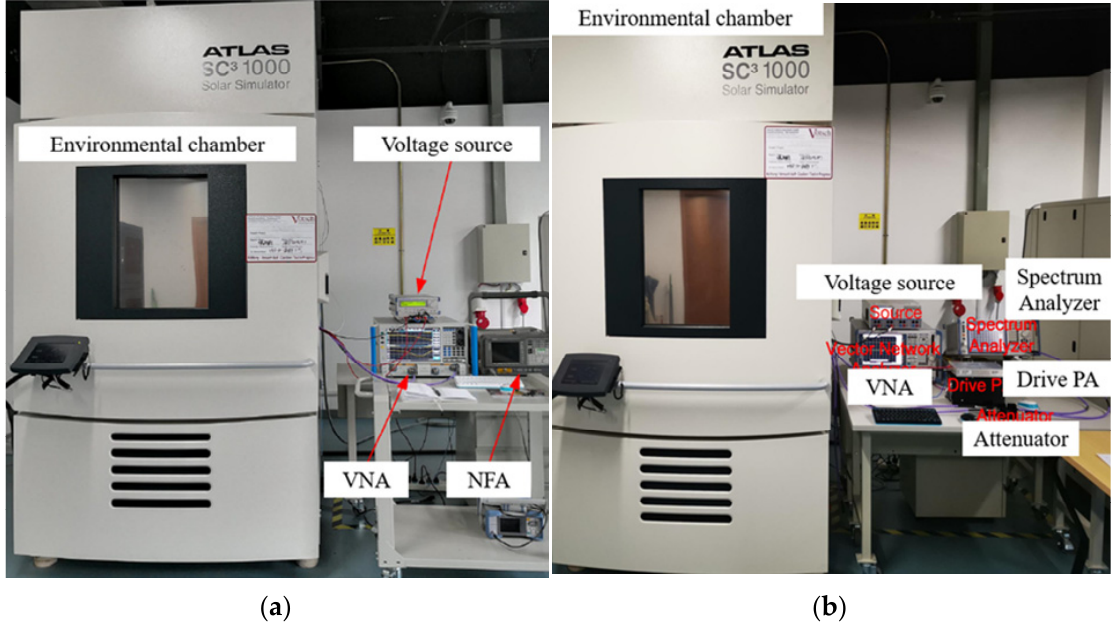
Figure 2. Measurement environment and setup: ( a ) S-parameters and noise figure (NF); ( b ) output power.